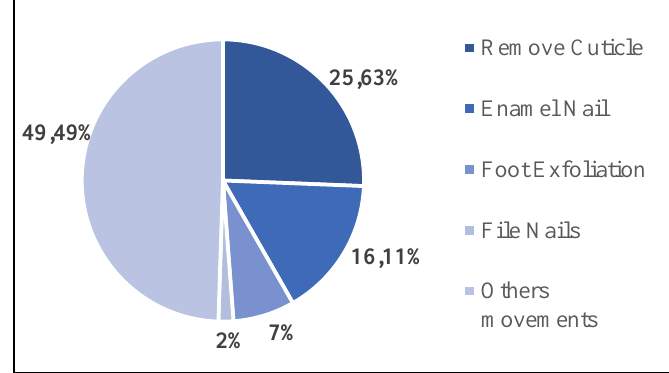
Figure 5: Graphic of the activities that add value to manicure and pedicure services.